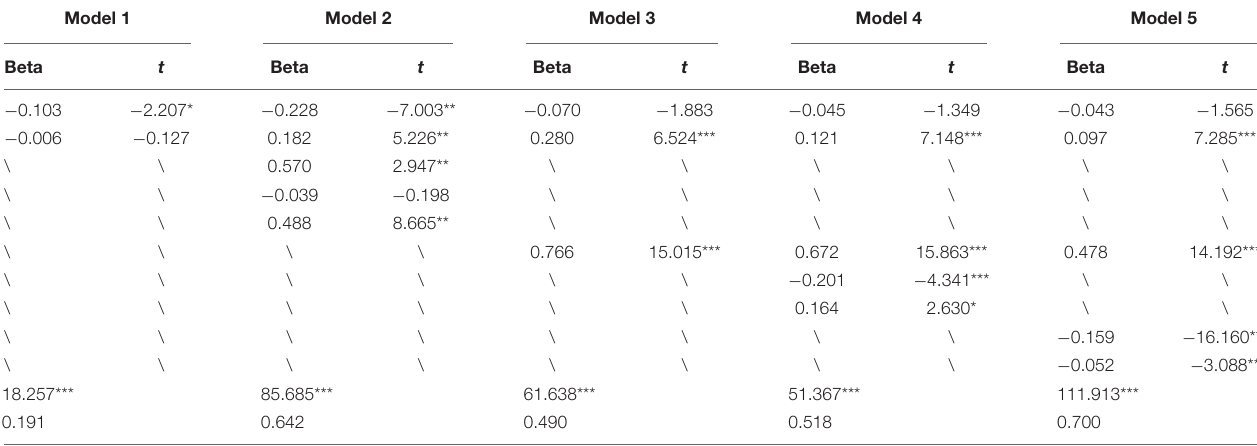
TABLE 5 | Results of regression analysis and moderating effective test.